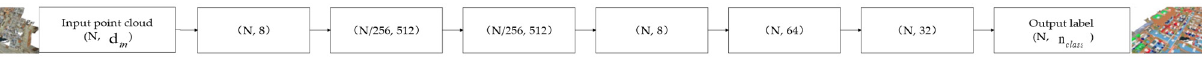
Figure 9. The process of semantic segmentation.